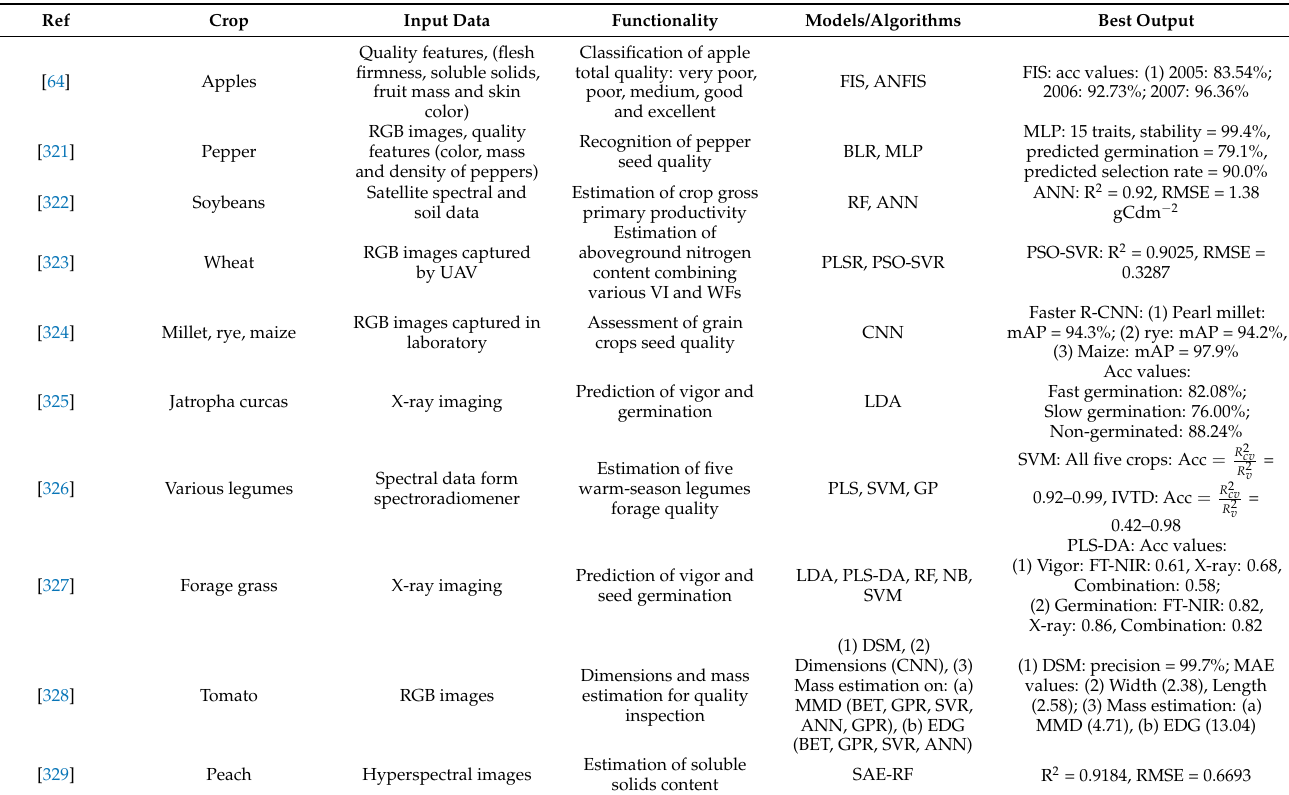
Table A5. Crop Management: Crop Quality.